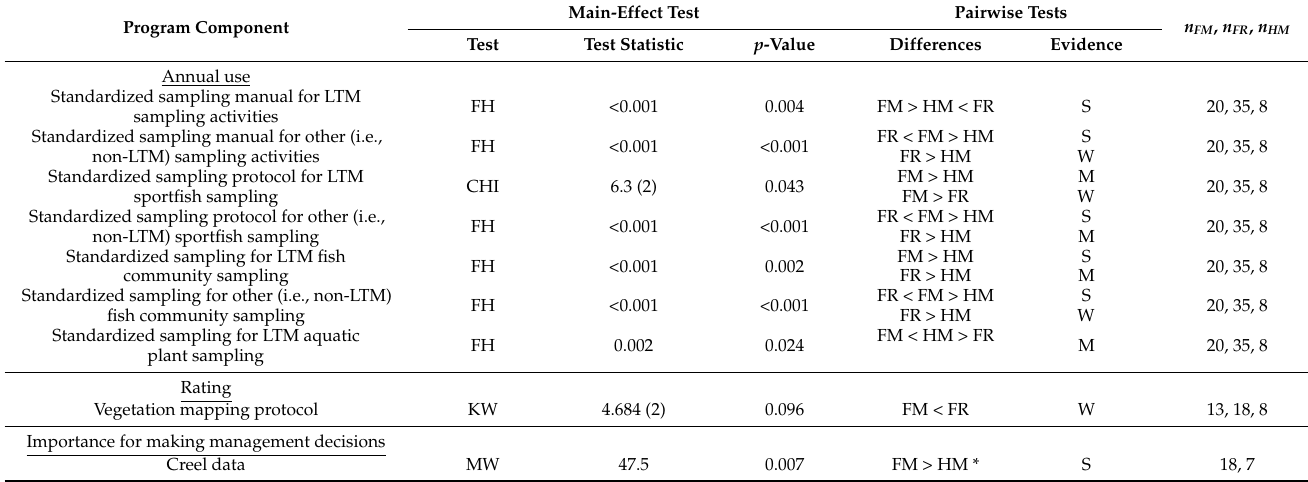
Table 7. Frequency of use and ratings of standardized sampling procedures and resources associated with Florida’s statewide Freshwater Fisheries Long-Term Monitoring (LTM) program compared among respondent functional roles (fisheries management, FM; fisheries research, FR; and habitat management, HM). Main-effect tests for frequency of use (chi-square, CHI; Freeman-Halton, FH) and ratings (Kruskal–Wallis, KW) and their associated test statistics (degrees of freedom where appropri- ate) and p -values are reported. Results of pairwise comparisons with either chi-square or Fisher’s tests (frequency of use) or Mann–Whitney U tests (ratings) are also included. Inequalities reported under “Differences” denote relative use and ratings (e.g., FR > HM indicates that fisheries researchers used a resource more frequently, or rated it more favorably, than habitat managers). Ratings range from 1 (very poor) to 5 (very good) and importance ranges from 1 (not at all important) to 5 (extremely important), whereas annual use is either 0 (not typically used) or 1 (typically used). “Evidence” denotes strength of evidence for each comparison, strong (S, p < 0.010), moderate (M, p = 0.010–0.049), or weak (W, p = 0.050–0.099), and n denotes number of respondents for each group. An asterisk (*) indicates that two groups rather than three were included in the analysis due to the importance of comparing management roles. The number of FM, FR, and HM respondents is denoted by n FM , n FR , and n HM , respectively. Only comparisons considered to have broad applicability are shown